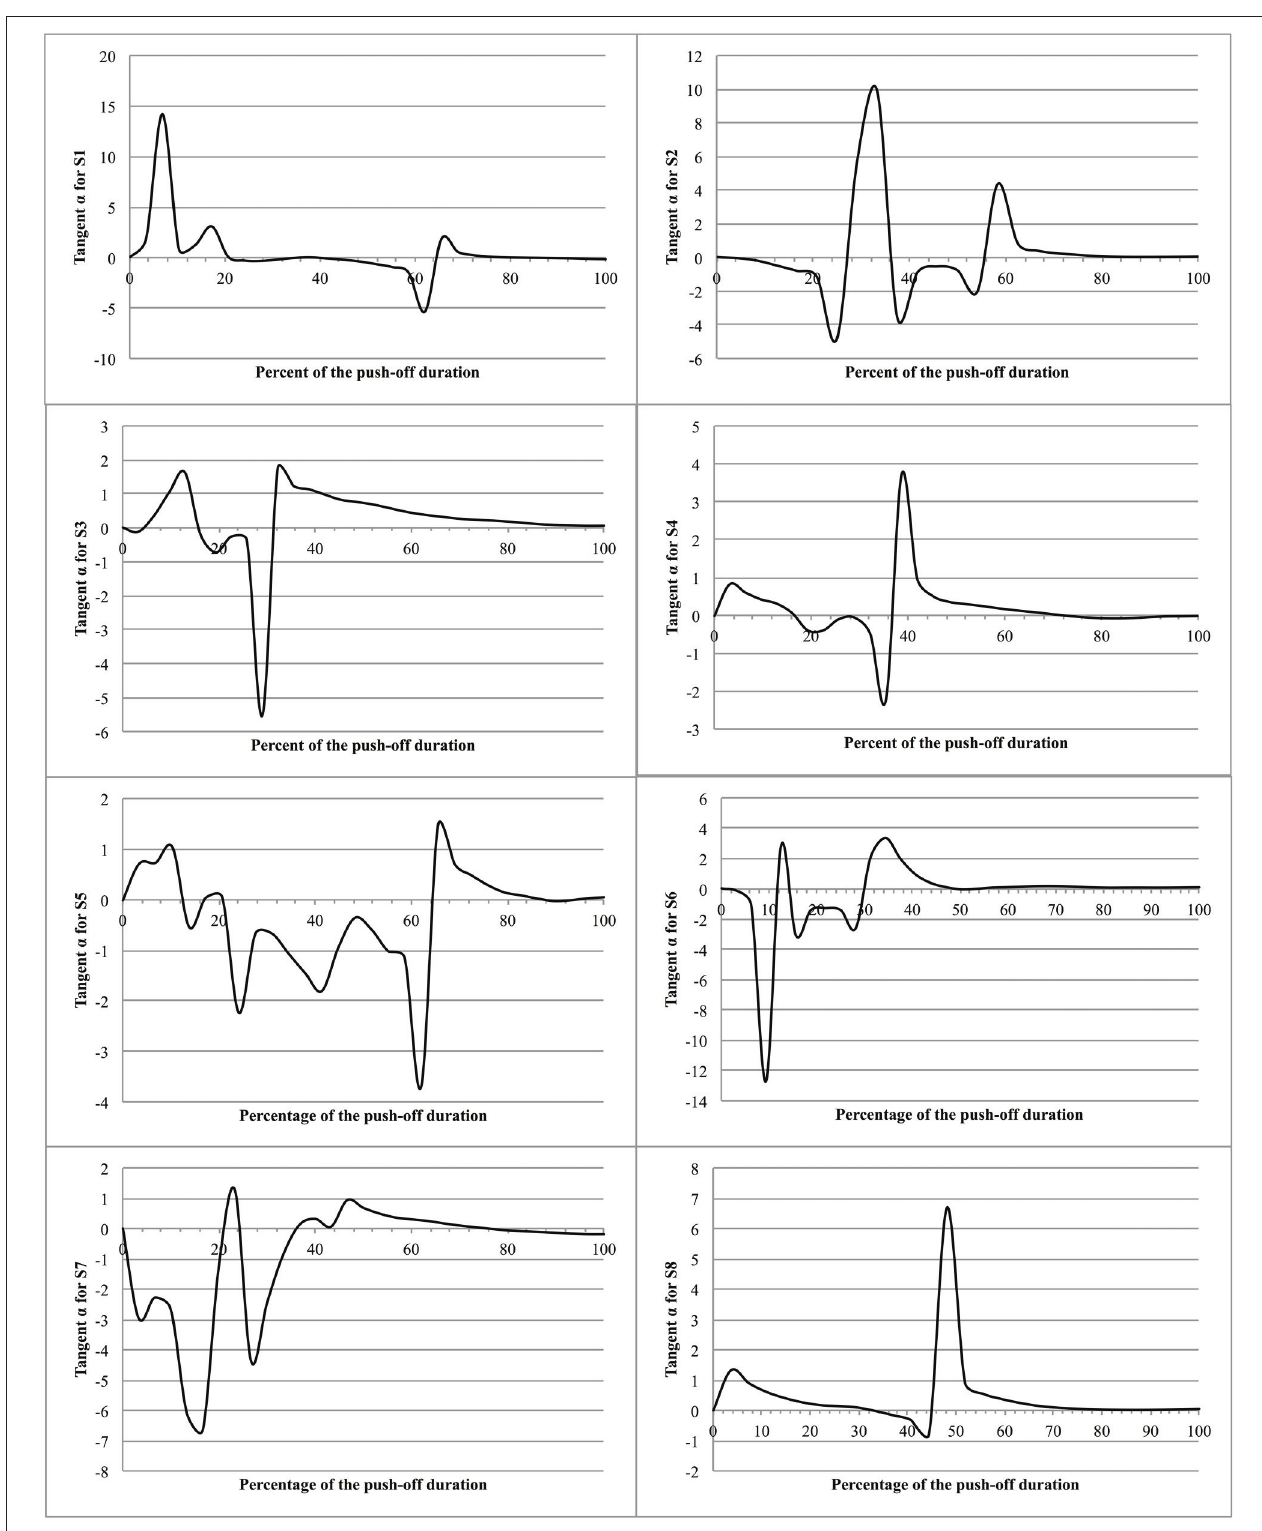
FIGURE 9 | Tangent α as function of time during push-off. The figure presents the eight jumps as function of the percent of the push-off time. The ordinate is the tangent to the α angle made by the velocity vector of the MC (V MC ) with the vertical passing by the point of application of the ground reaction force (tangent α = V MCx /V MCz